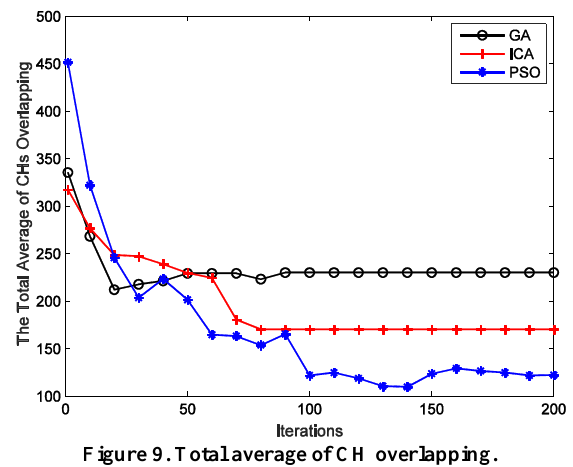
Figure 9. Total average of CH overlapping.